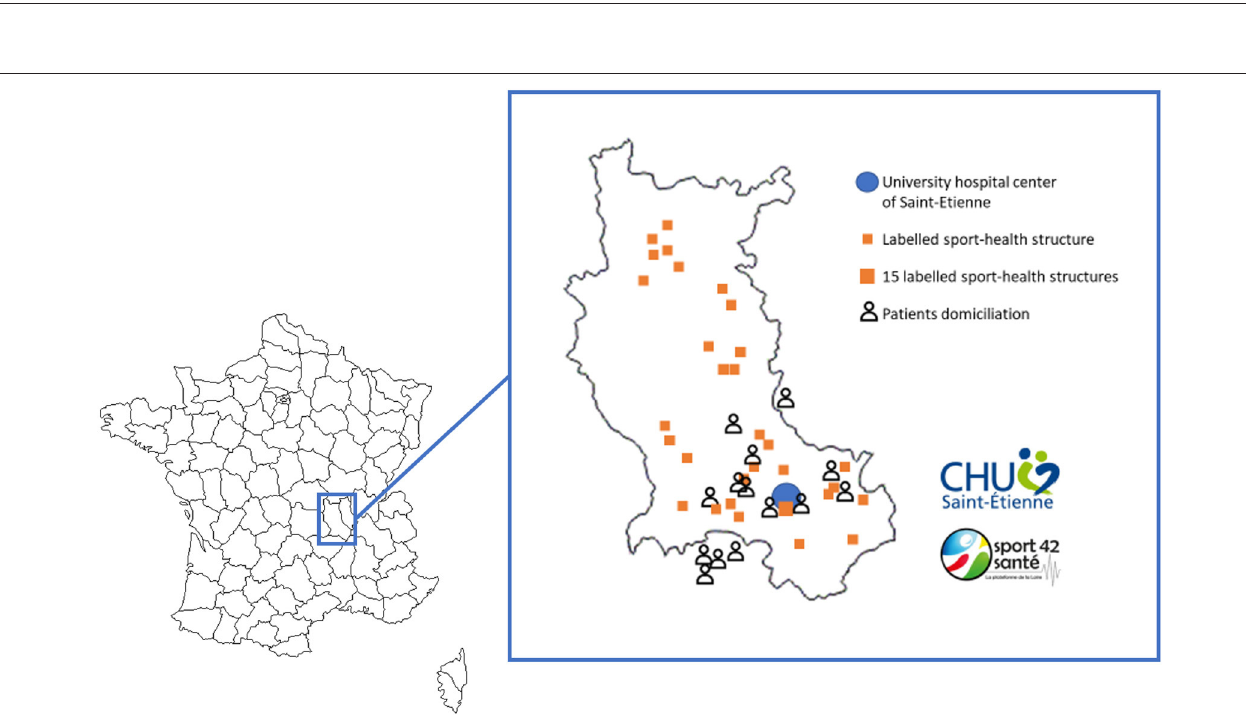
FIGURE 3 | Mapping of Health Sport House (Loire department) and patients’ domiciliation. After the CoviMouv’ program, patients are invited to sustain an adapted practice of physical activity near their home in labeled structures.